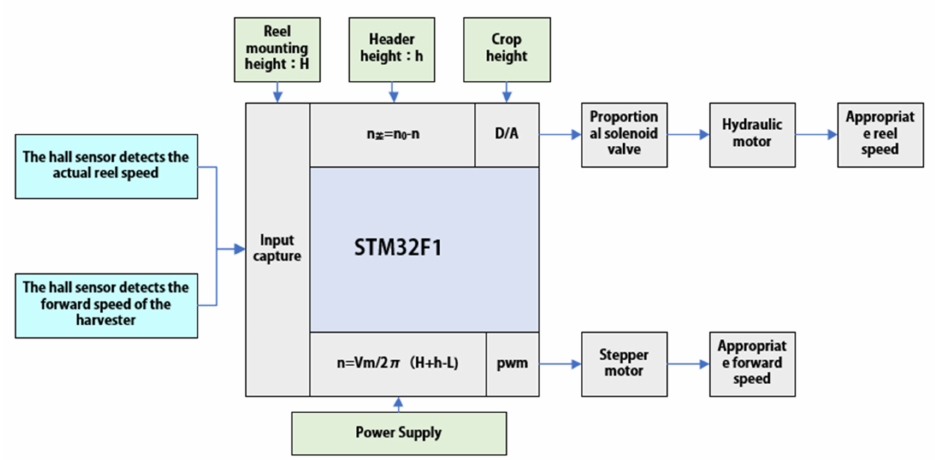
Figure 2. Flow chart of matching adjustment between rotation speed and forward speed of pulling